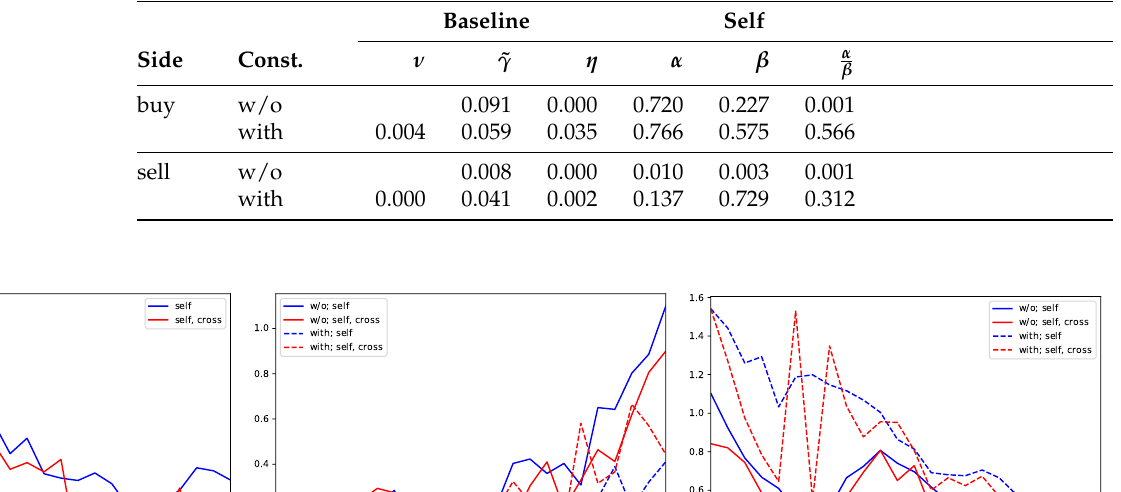
c. Models with self-excitation and models with self and cross-excitation.